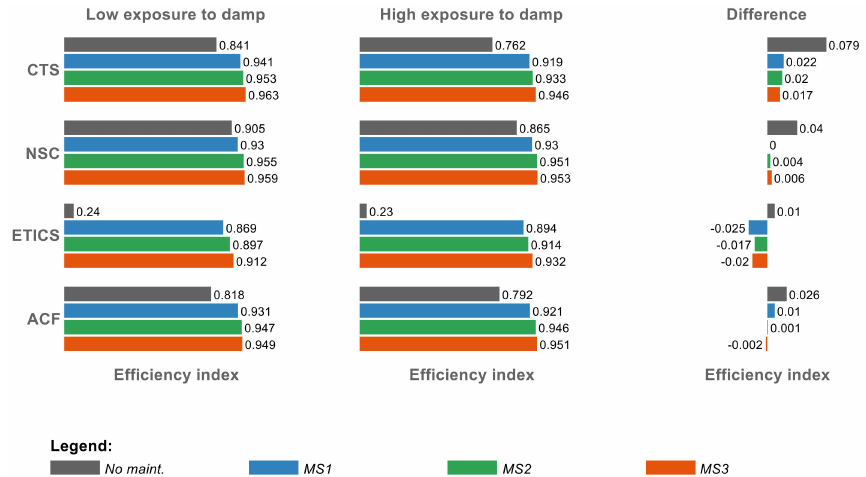
Figure 5. Comparison of the efficiency index according to exposure to damp for a time horizon of 80